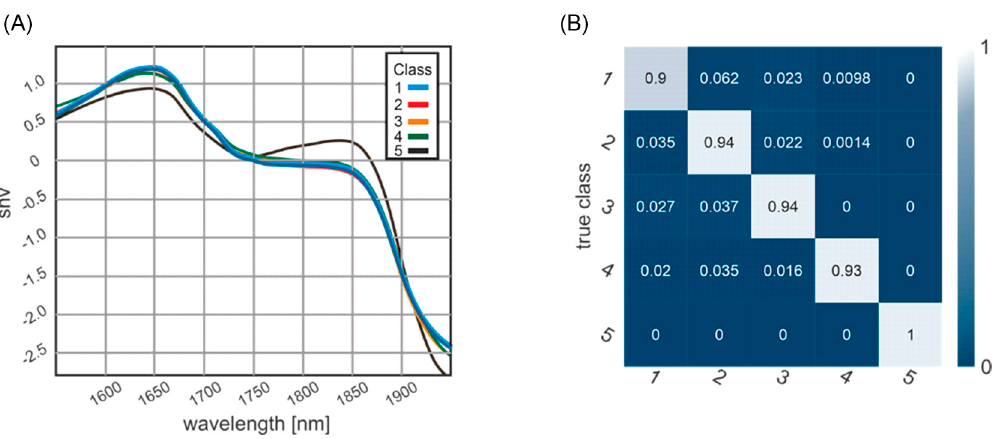
Figure 4. ( A ) Mean spectra are shown for the five different age classes: class 1 with PMI of 0–2 weeks (blue line; n = 32), class 2 with PMI of 2 weeks–6 months (red line; n = 46), class 3 with PMI of 6 months–1 year (orange line; n = 11), class 4 with PMI of 1–10 years (green line; n = 10), and class 5 with PMI of >100 years (black line; n = 5). ( B ) The confusion matrix of ANN classification shows classification accuracies between 0.90 and 1.